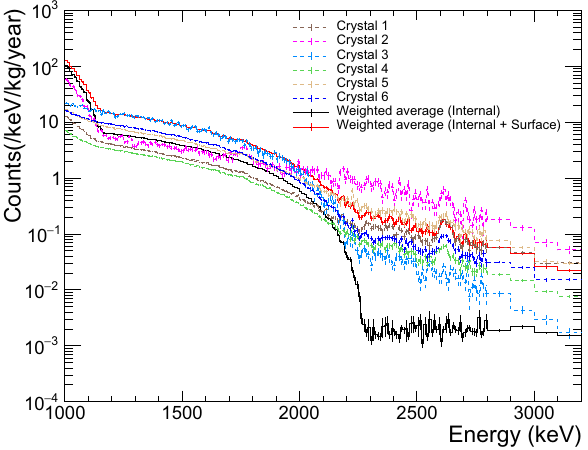
Fig. 13 Simulated energy distributions of β/γ events from both inter- nal and surface contaminations of the crystal detectors. Weighted aver- aged spectra from internal and surface (red solid line), and internal only (black solid line) contaminations are shown